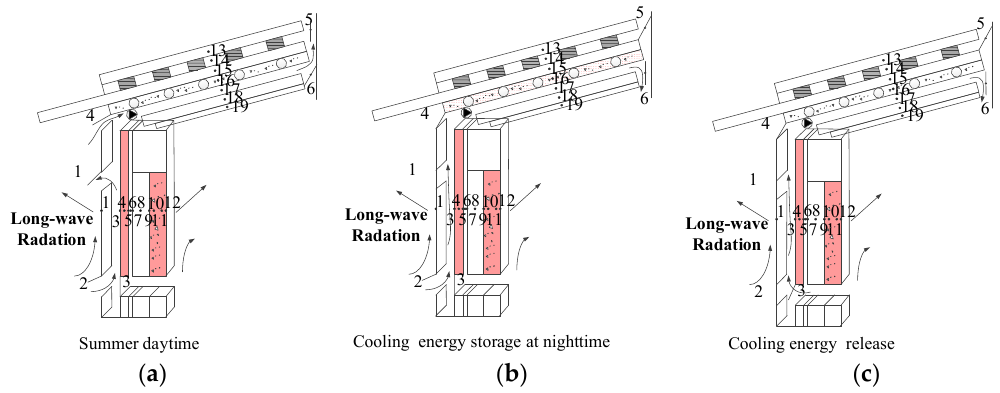
Figure 2. Computational nodes and heat transfer of three typical operational modes.